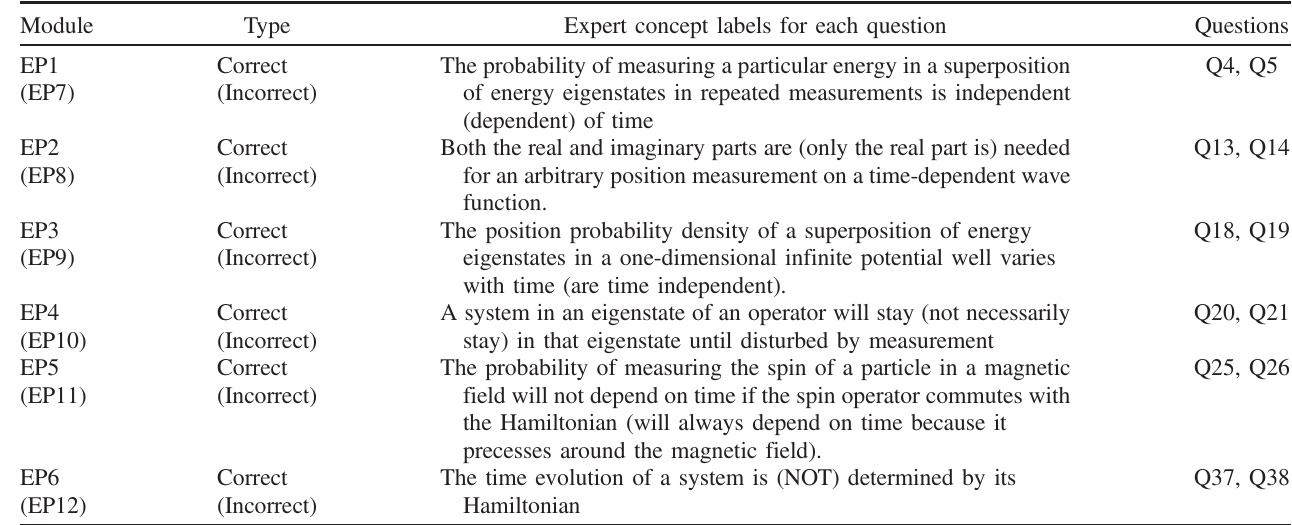
TABLE IV. Modules identified in the QMCA that consist of explain pairs. The modules are labeled as in Fig. 3. The expert interpretation of each module is also given. Module Expert concept labels for each